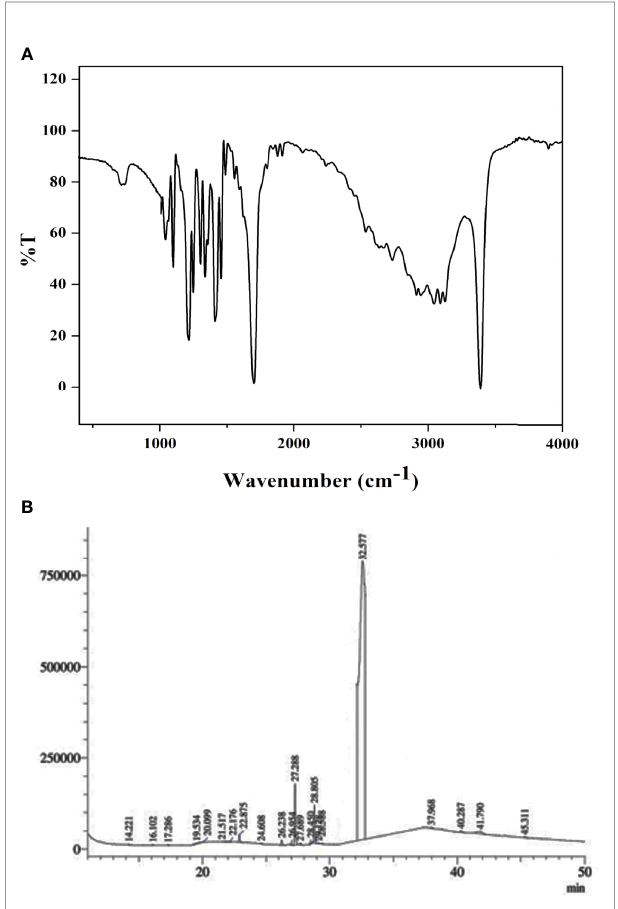
FIGURE 2 | FTIR (A) and GC-MS (B) analysis of p`uri fi ed fraction 4 obtained from ethyl acetate extract of N. exhalans